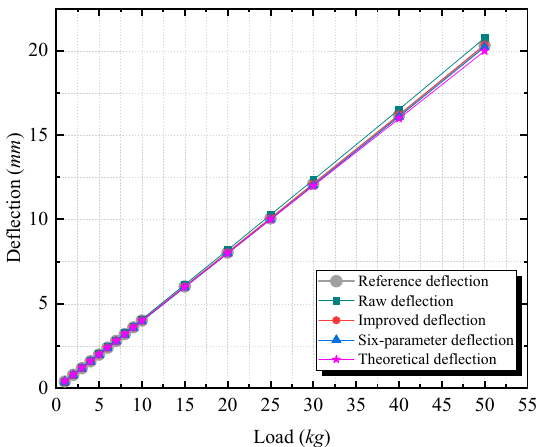
Figure 14. The deflection measurement results of the reference deflection, the raw deflection, the improved deflection, the six-parameter deflection, and the theoretical deflection at the same loads.